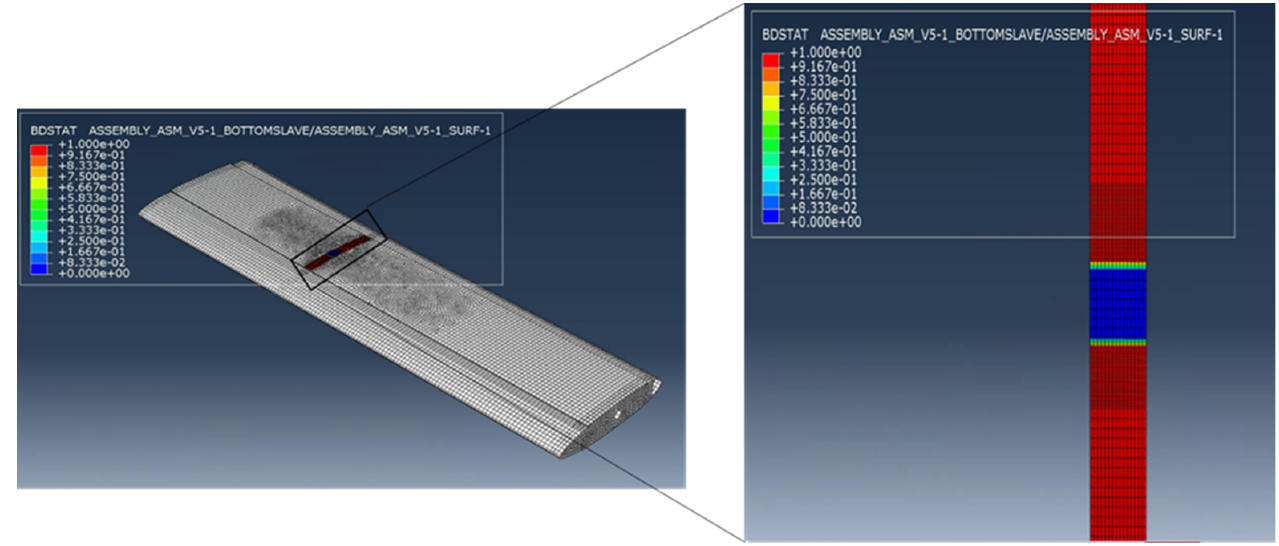
Figure 8. BDSTAT plot representing the cracked region between the upper skin and the middle. Different case simulations were carried out for the different values of the applied loading scenarios by using the flight operating load spectrum. The simulation was run for 8000 flight hours (FHs), and the crack propagation plots are analyzed. The first case scenario represented the actual loading condition with the magnitude of shear forces. The other three case scenarios were simulated to observe the fatigue crack propagation. Table 2 shows the case simulation scenarios. Table 2. Case simulation scenarios. Case Simulation